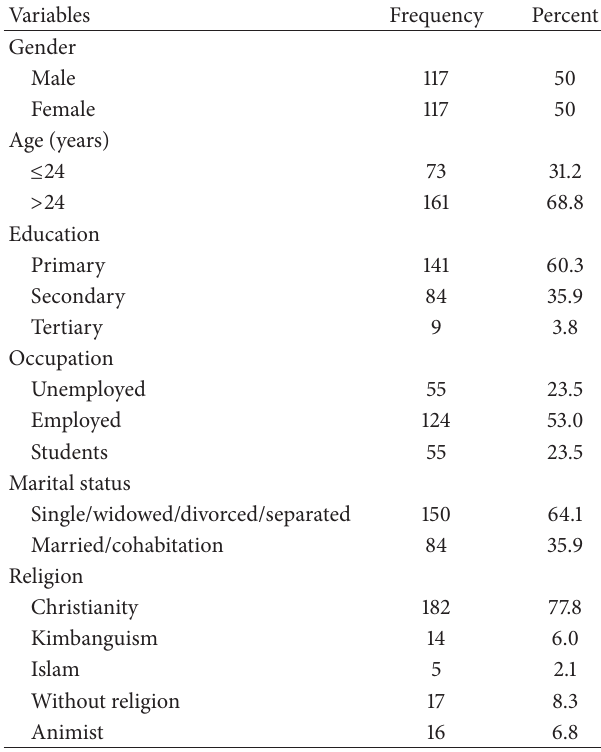
Table 1: Sociodemographics and characteristics of the 234 study